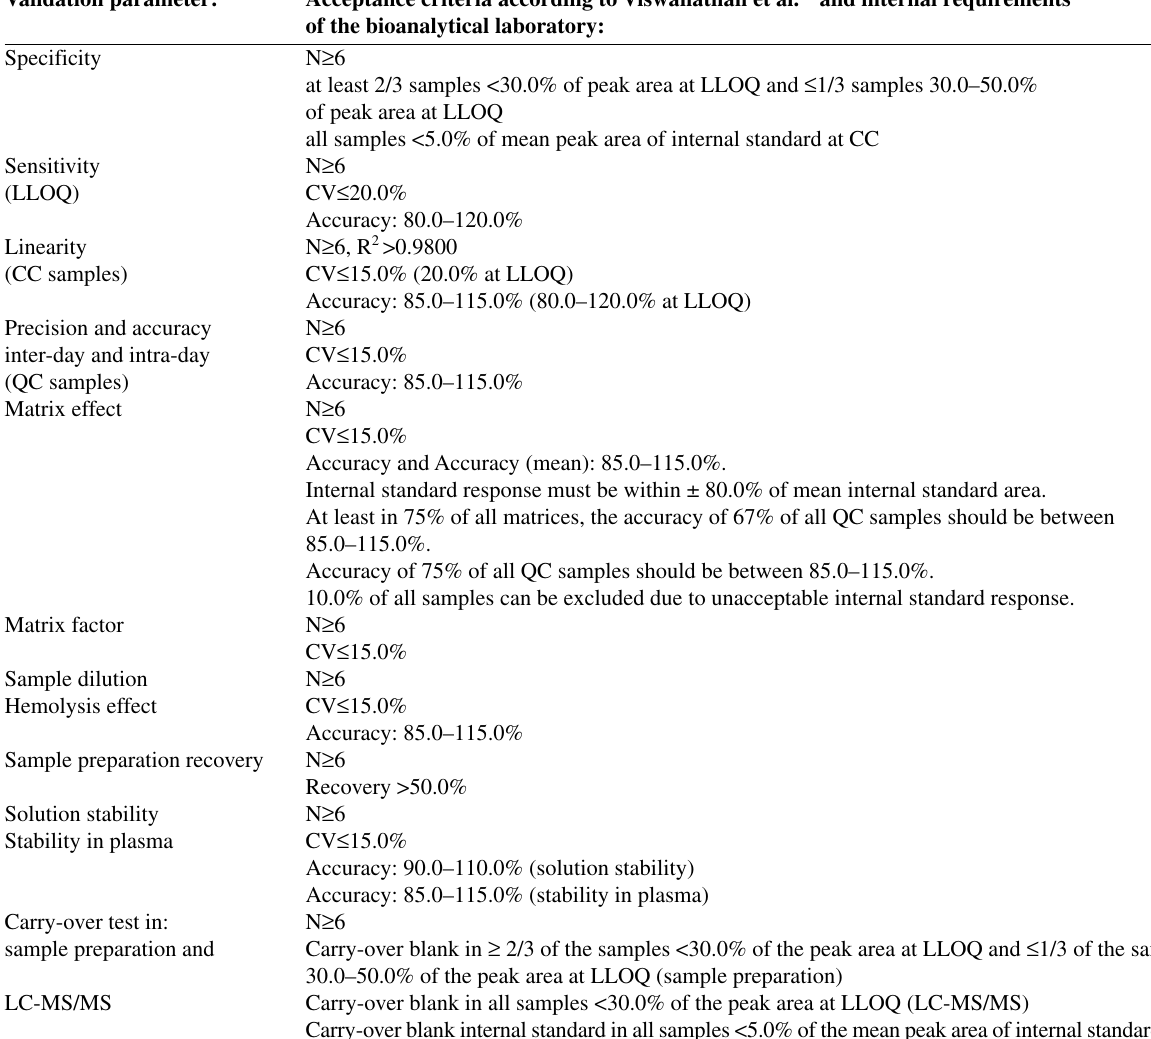
Table 1: Acceptance criteria for validation